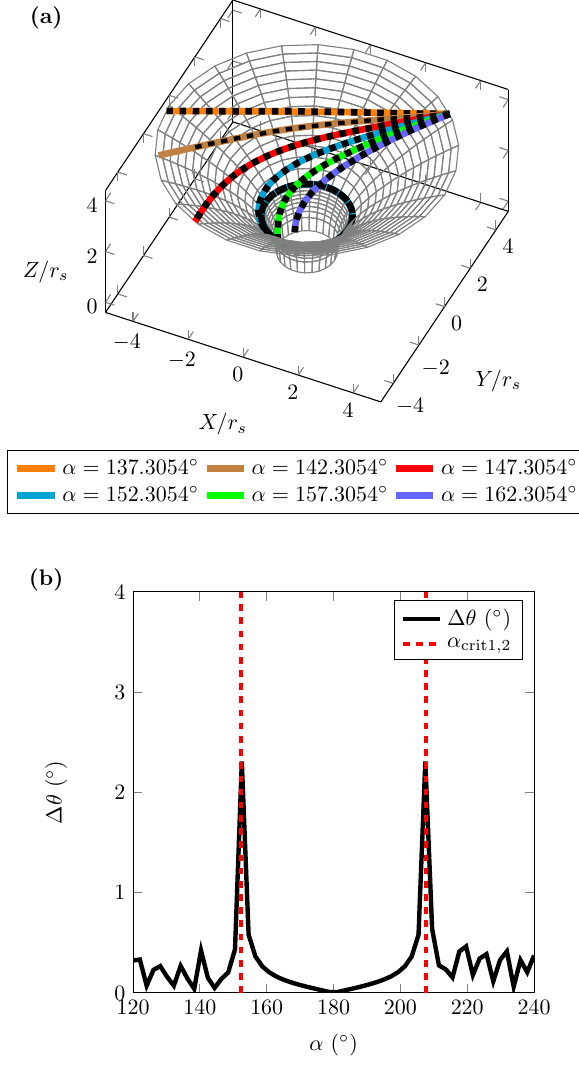
Fig. 4 Simulation results for Schwarzschild BH case: r s = 1, R i = 5 r s , φ i = 45 ◦ , and (cid:14)μ max = 10 − 2 r s . a Geodesics generated for dif- ferent emission angles α . Color solid lines are results obtained with the proposed algorithm and black dashed lines are obtained via the orbital equation. b Angulardeviationversus.emissionangle α insidetherange: 120 ◦ − 240 ◦